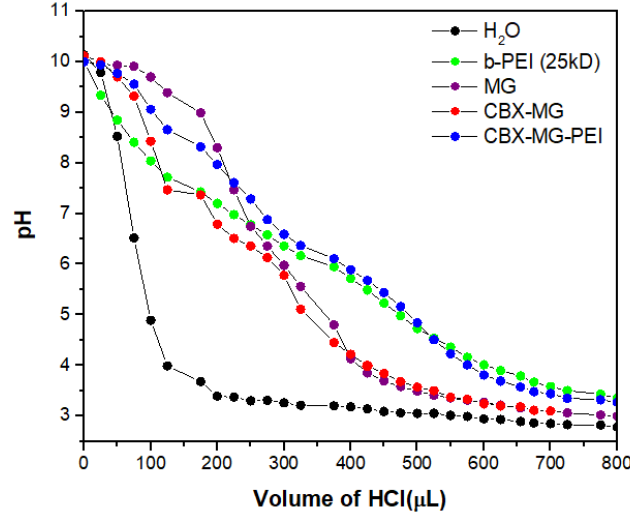
Figure 5. Determination of the buffering capacity of copolymer and precursors.